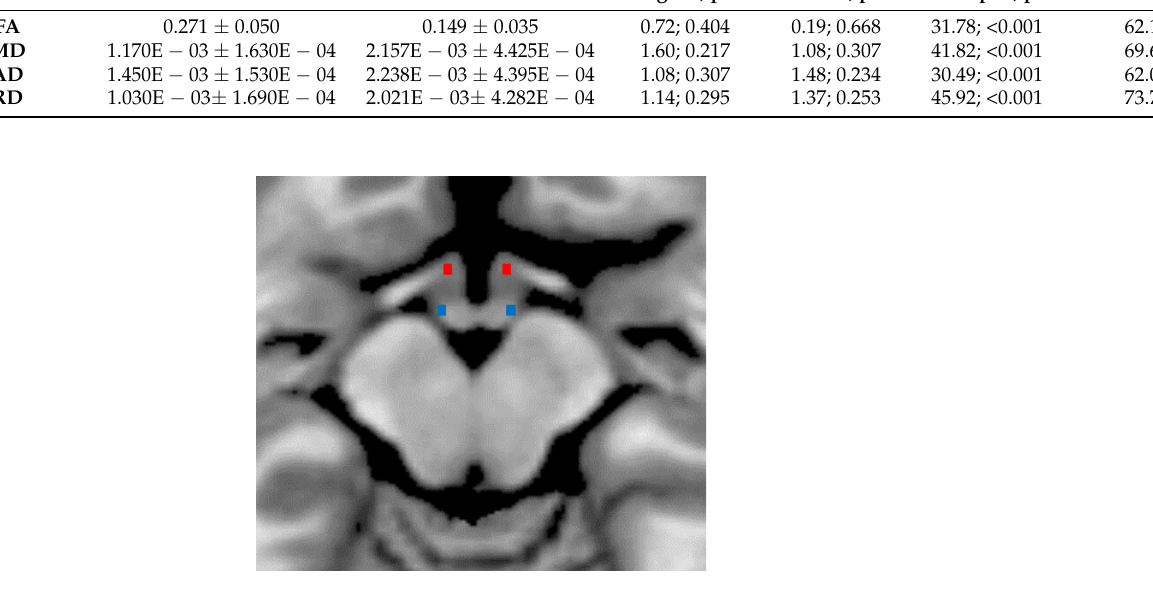
Figure 1. Bilateral anterior (in red) and posterior (in blue) hypothalamic regions of interest are shown on axial slice of an MRI template (T1-weighted MNI 2 mm). Table 2. Mean ± standard deviation for the hypothalamus fractional anisotropy (FA), mean diffusivity (MD), axial diffusivity (AD), and radial diffusivity (RD) in HC and MI. General linear models of DTI metrics inferences with the percentage of variation in the response that is explained by the model, adjusted for the number of predictors.